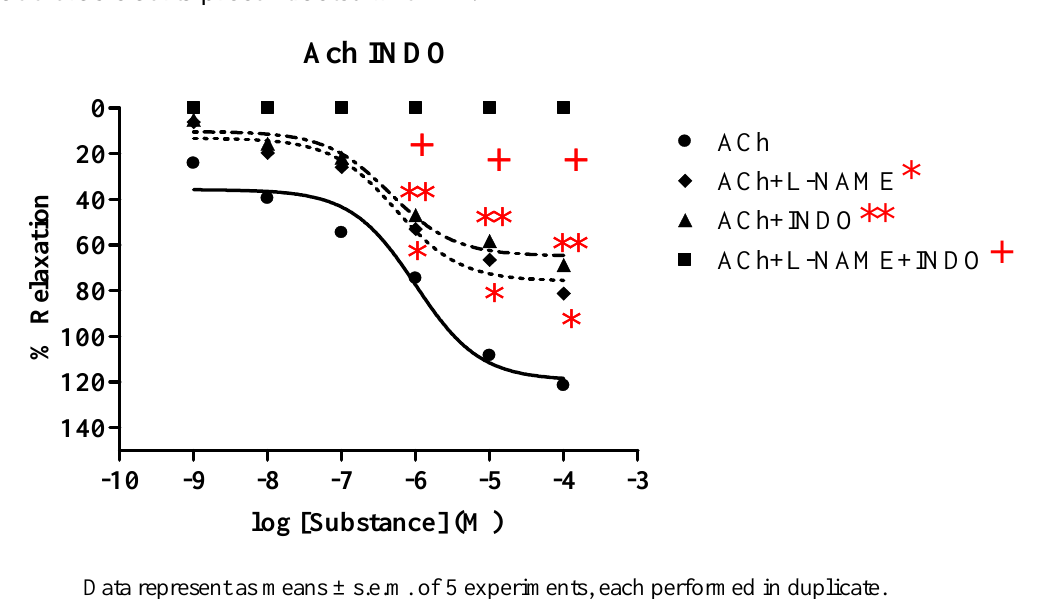
Figure 7. Effect of ACh in the presence of L -NAME plus INDO on the vascular function of rat thoracic aorta precontracted with PE.